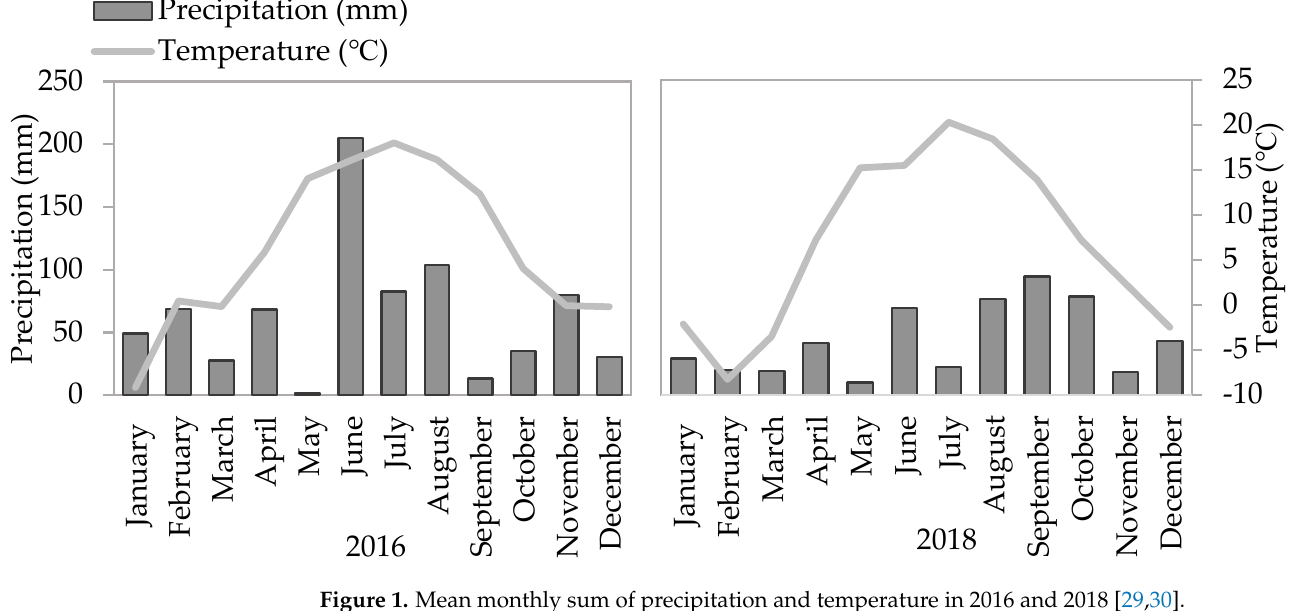
Figure 1. Mean monthly sum of precipitation and temperature in 2016 and 2018 [29,30].